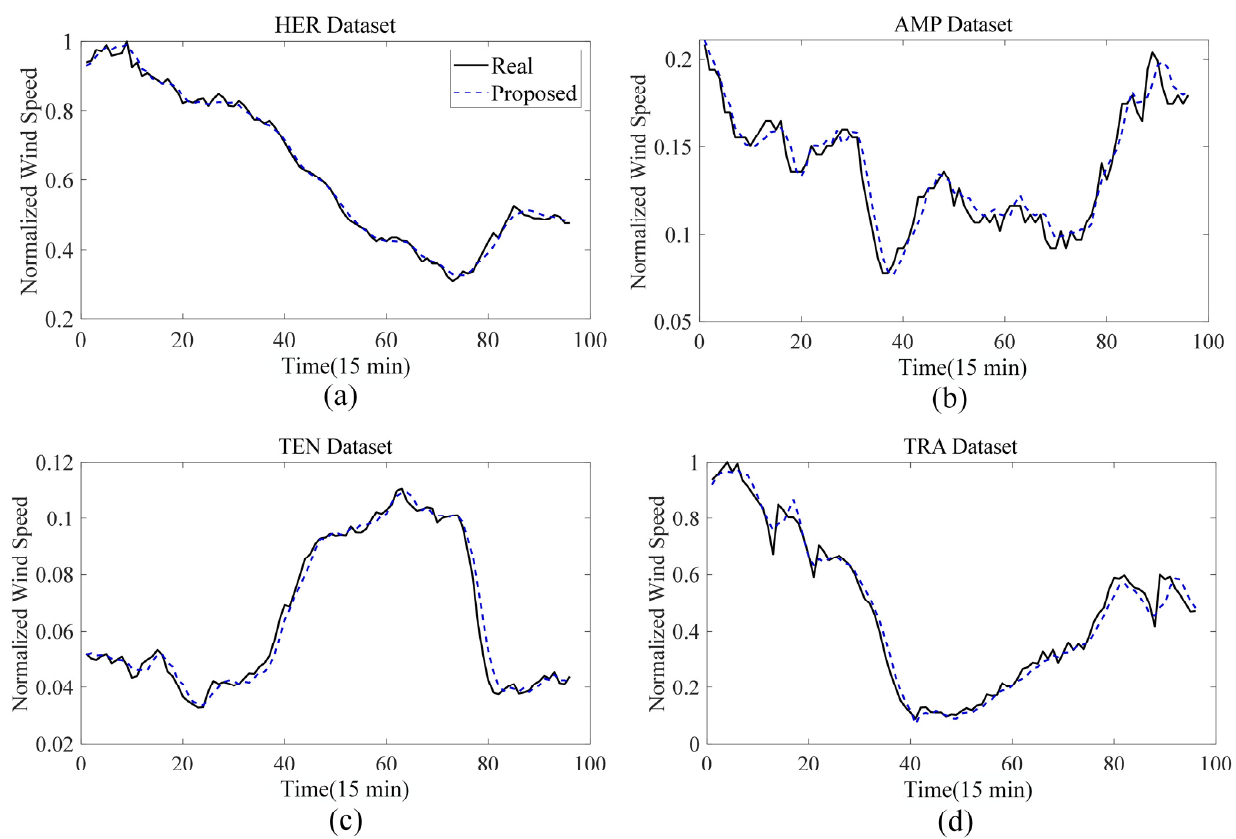
Figure 4. Wind speed fitting curves of the proposed model for four wind datasets: ( a ) experiments results on HER wind datasets; ( b ) experiments results on AMP wind datasets; ( c ) experiments results on TEN wind datasets; ( d ) experiments results on TRA wind datasets.